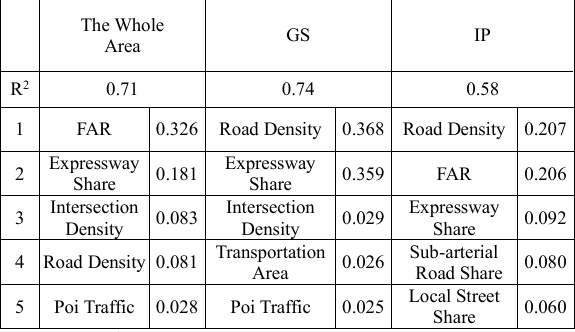
Table 8 R 2 and feature importance ranking according to